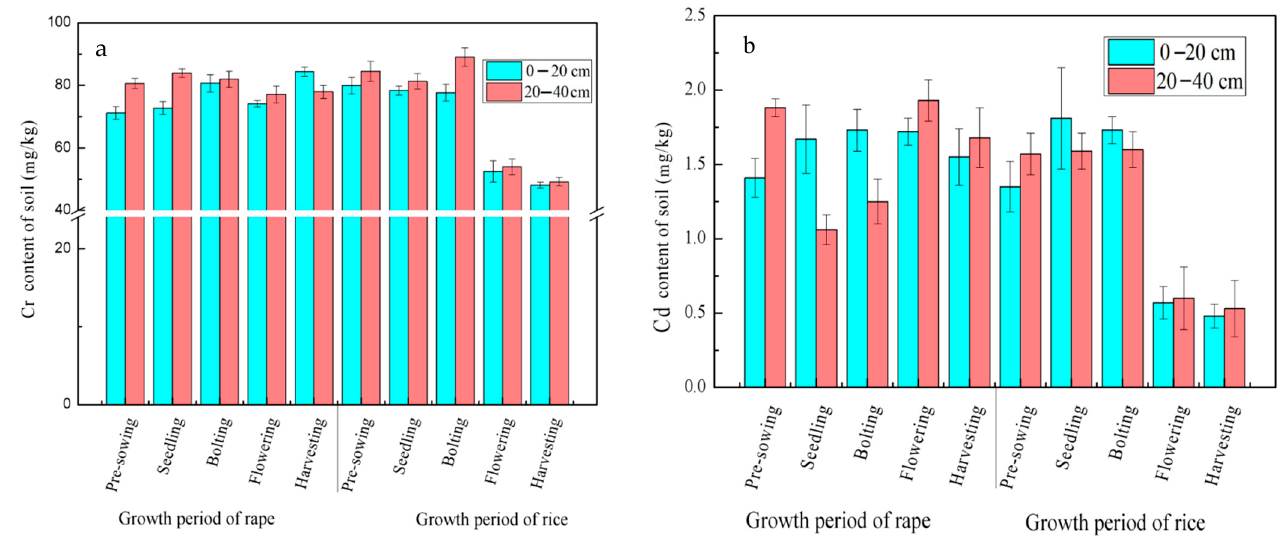
Figure 4. Change of heavy metal Cr ( a ) and Cd ( b ) in soil during rice–rape rotation.